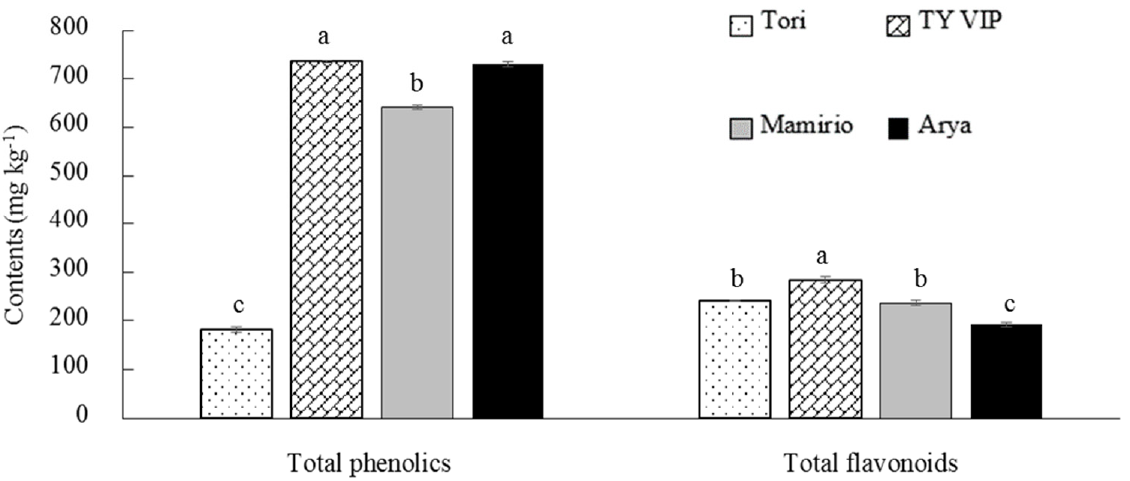
Figure 4. Total phenolics and flavonoids content of ‘Tori’, ‘TY VIP’, ‘Mamirio’, and ‘Arya’ tomato cultivars at the commercial pink ripening stage. The bars with different letters indicate a significant difference ( p < 0.05) between cultivars. The vertical bars represent the standard error of the means ( n = 5).